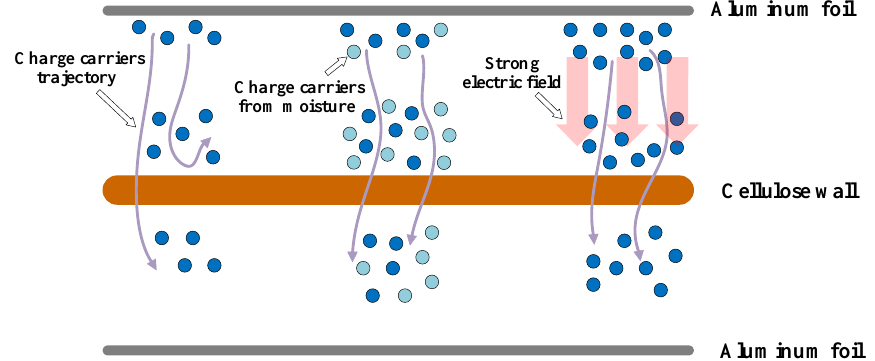
Figure 11. Interface polarization current of dampened cellulose polymer insulation in bushing under different DC voltages.